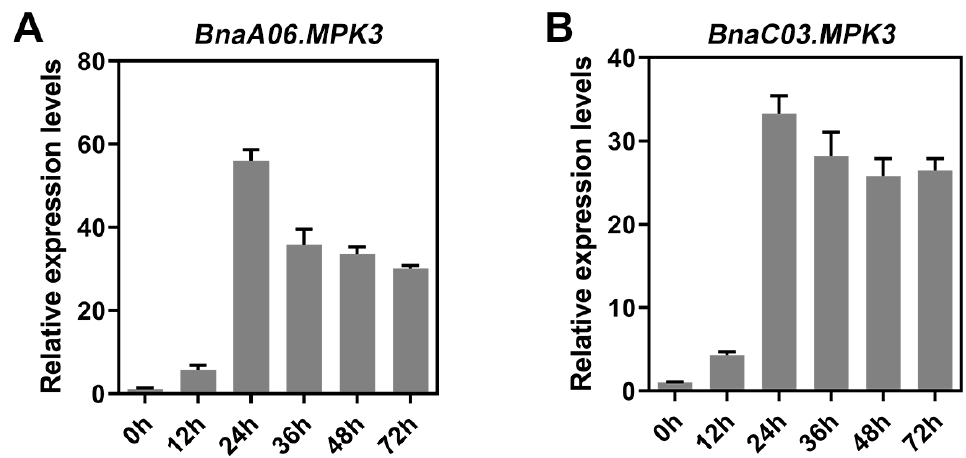
Figure 4. Expression analysis of two BnMPK3 copies in response to Sclerotinia infection. Induced expression profiles of BnaA06.MPK3 ( A ) and BnaC03.MPK3 ( B ) were identified at 0 h, 12 h, 24 h, 36 h, 48 h, and 72 h after inoculation with S. sclerotiorum . Data are shown as means ± SD ( n = 3).